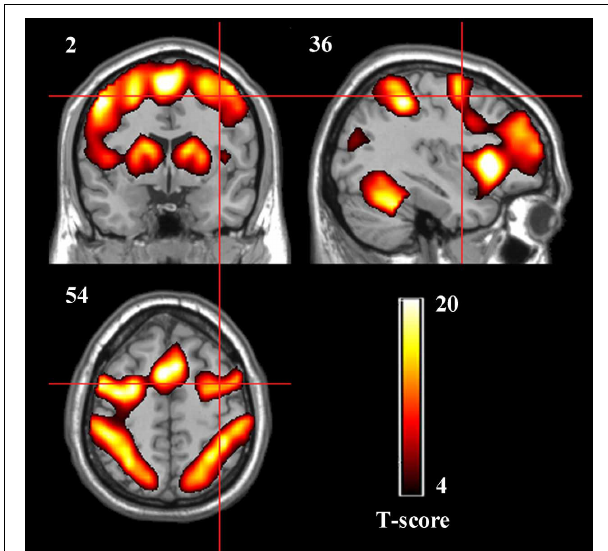
FIGURE 3 | Group activation maps of the two groups together during the rtfMRI imagery training ( p < 0 . 05, cluster size > 41, FDR correction). The peak value in the right dPMA was located at the MNI coordinates x = 39, y = − 1, z = 42.